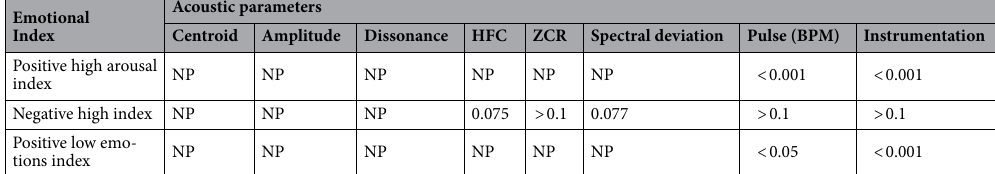
Table 4. Association of acoustic parameters predictors for each emotional index, based on a generalized additive model (GAM). NP parameters considered no predictors for model selected, HFC high frequency content, ZCR zero crossings rate, BPM beats per